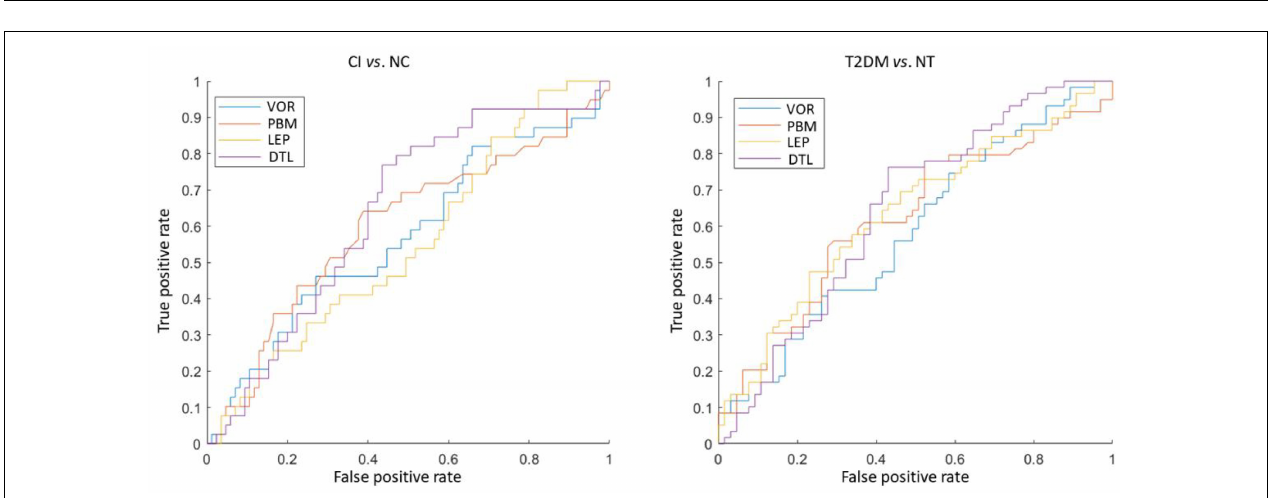
FIGURE 2 | Performance of four different feature extraction methods in both the tasks of discriminating cognitive impairment (CI) subjects from normal cognition (NC) subjects (left), as well as type 2 diabetes mellitus (T2DM) subjects from individuals without T2DM (NT) (right).